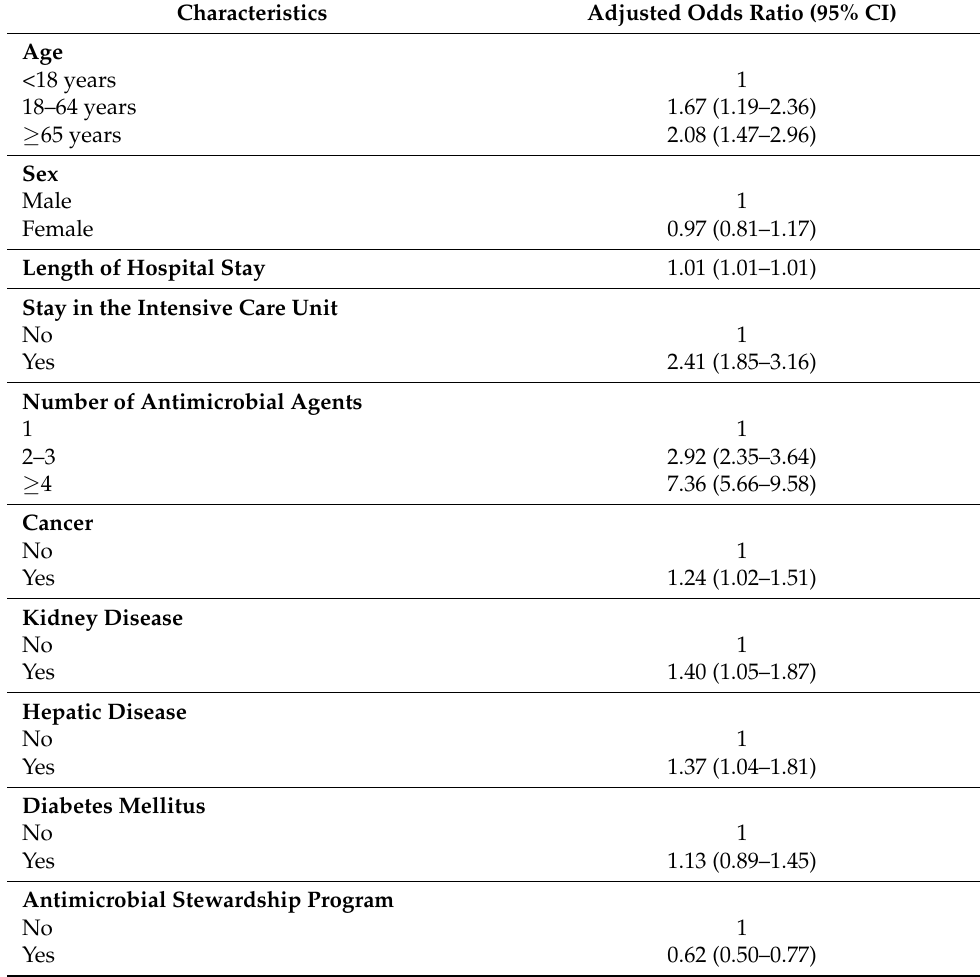
Table 3. Multivariate logistic analysis of factors associated with antimicrobial-related adverse drug